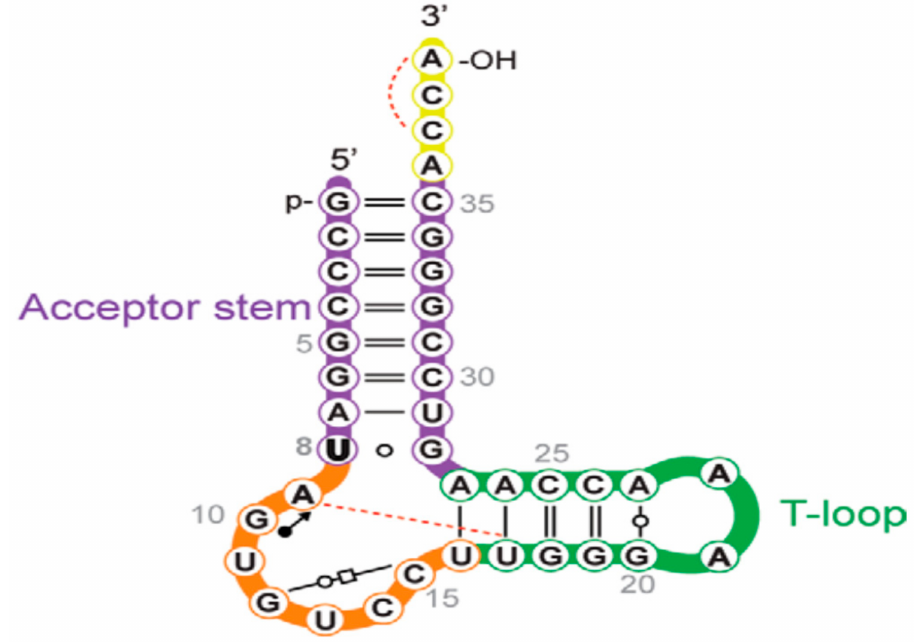
Figure 3. Current minimal substrate for ThiI. Reprinted with permission from reference